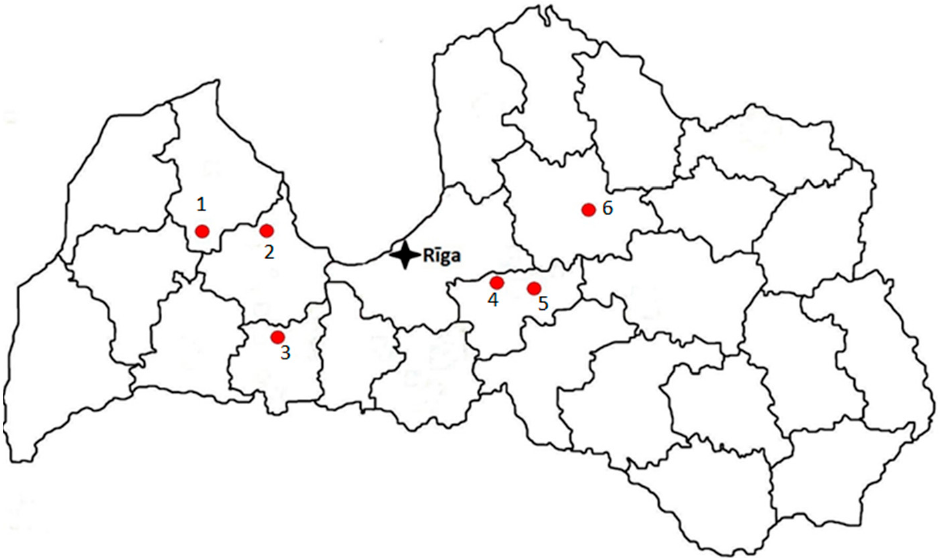
Figure 1. Locations of stump removal sample plots (1—Dursupe, 2—Stende, 3—Jaunpils, 4—Tinuzi, 5—Rembate, 6—Nitaure). 5—Rembate,